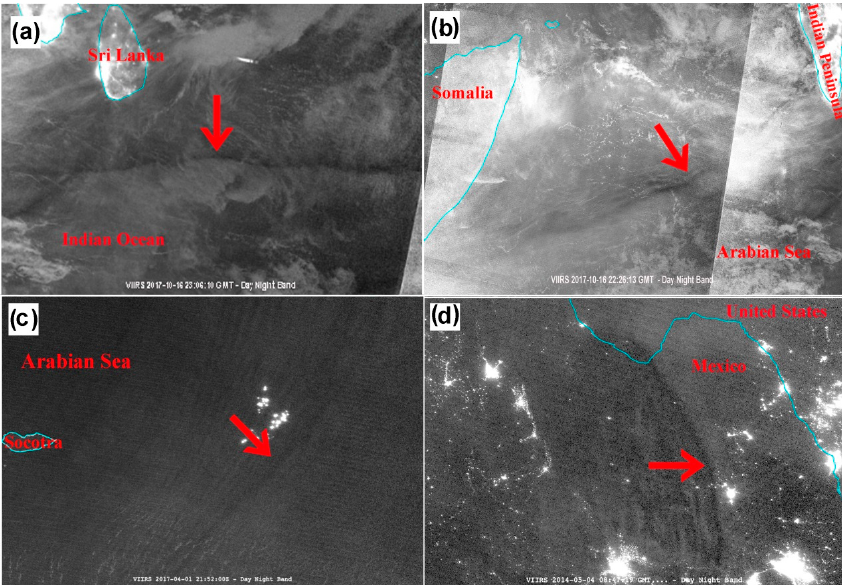
Figure 1. Mesospheric bore events observed by Suomi National Polar-orbiting Partnership Visible/Infrared Imaging Radiometer Suite Day/Night Band (Suomi-NPP VIIRS DNB) over: ( a ) Indian Ocean, at 23:06 UT on 16 Oct 2017; ( b ) Arabian Sea, at 22:26 UT on 16 Oct 2017; ( c ) Arabian Sea, at 21:52 UT on 4 Apr 2017; ( d ) Mexico, at 8:47 UT on 4 May 2014. The red arrows indicate the mesospheric bore fronts and their propagation directions.